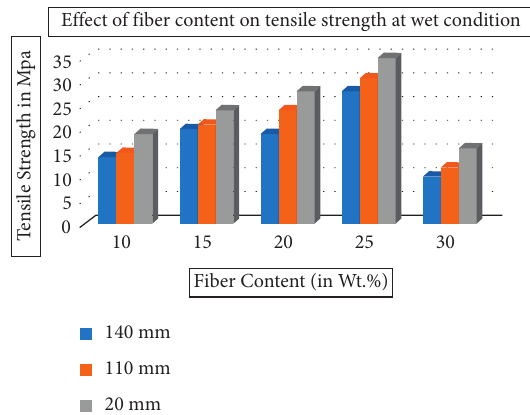
Figure 8: Tensile behavior of dry and wet conditions of composites with respect to the fiber